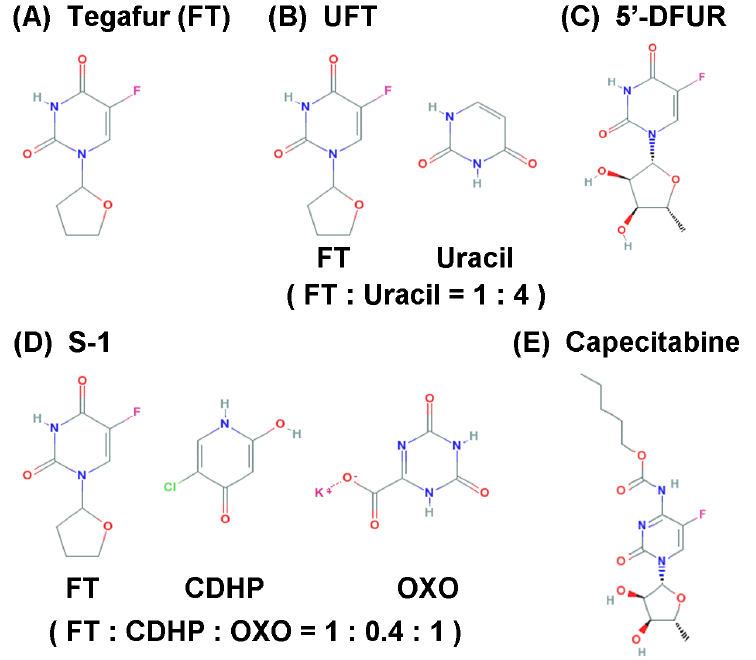
Figure 2. Structures of oral 5-FU drugs. ( A ) Tegafur; ( B ) UFT; ( C ) 5’-DFUR; ( D ) S-1; ( E )